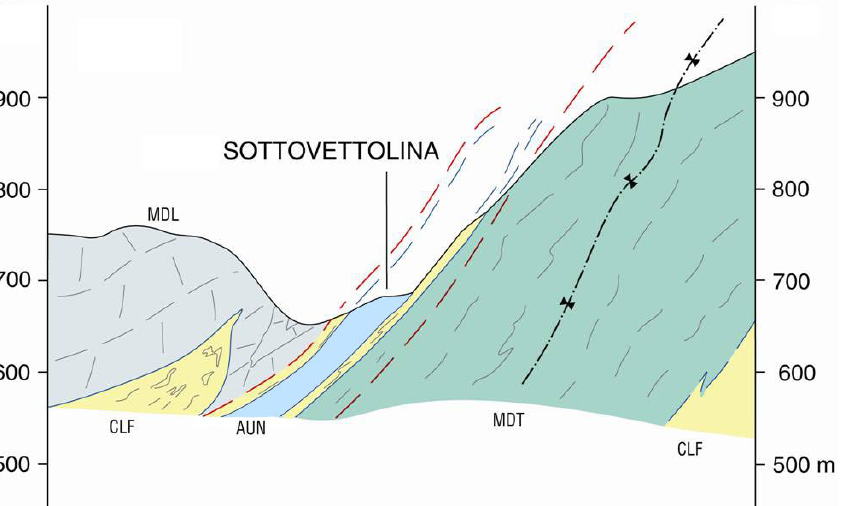
Figure 2. Geological cross-section of the Sottovettolina quarry and surrounding area. (Map legend is as follows: MDL—dolomitic marble; AUN—marble; CLF—cherty meta-limestone; MDT—radio- larian chert). The geological cross-section is referred to as Nr. 3 of Figure